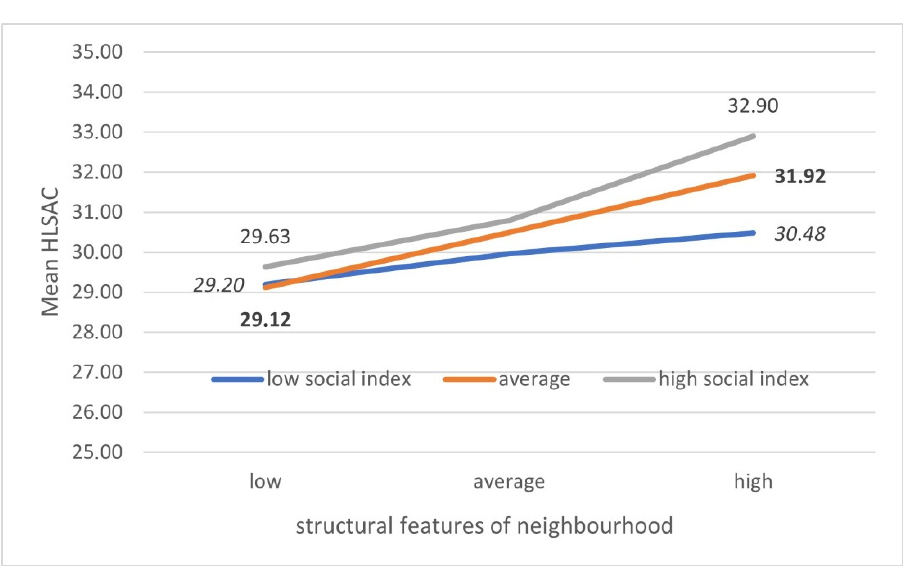
Figure 1. Average health literacy in school-aged children (HLSAC) level by social and structural neighbourhood feature (adjusted for gender, age, country, and family affluence (FAS)).